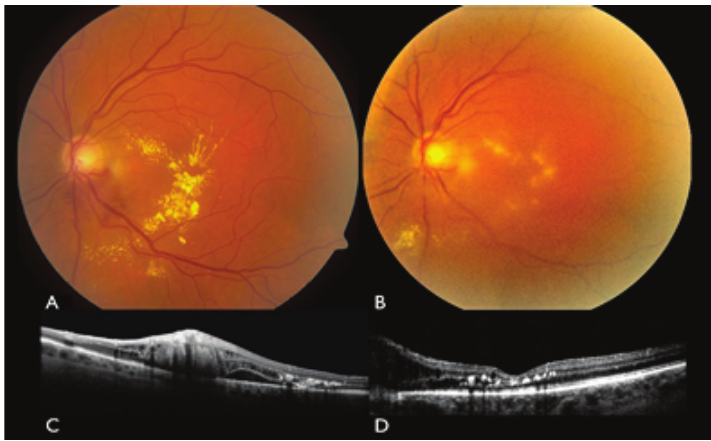
Figure 3. Fundus photograph of the left eye of a patient with juxtapapillary retinal hemangioblastoma associated with macular edema and subretinal fluid and lipid exudation (A) before and (B) 20 months after PDT. PDT resulted in the regression of the tumor and the resolution of the macular edema confirmed by optical coherence tomography (OCT) (C, D).